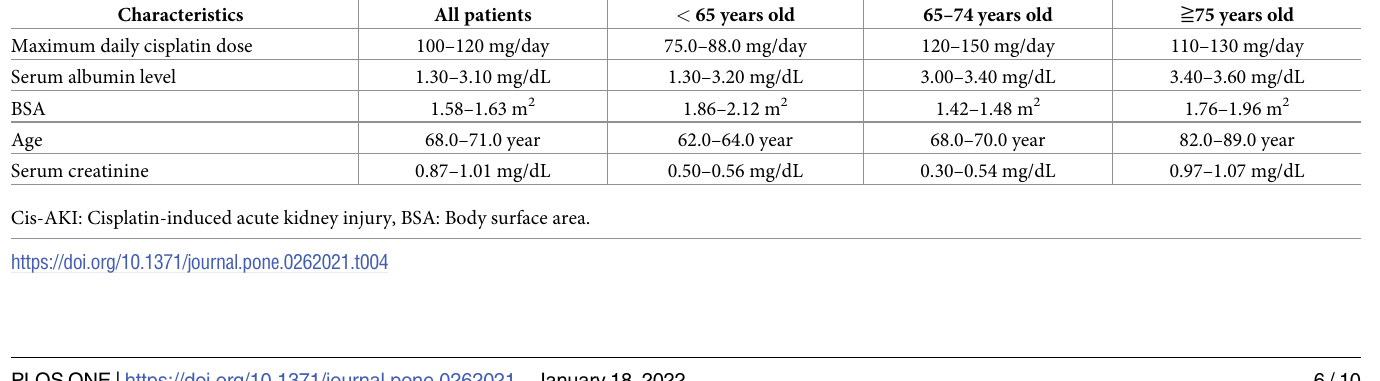
Table 4. The parameter range of highest contribution as a prediction factor of Cis-AKI.